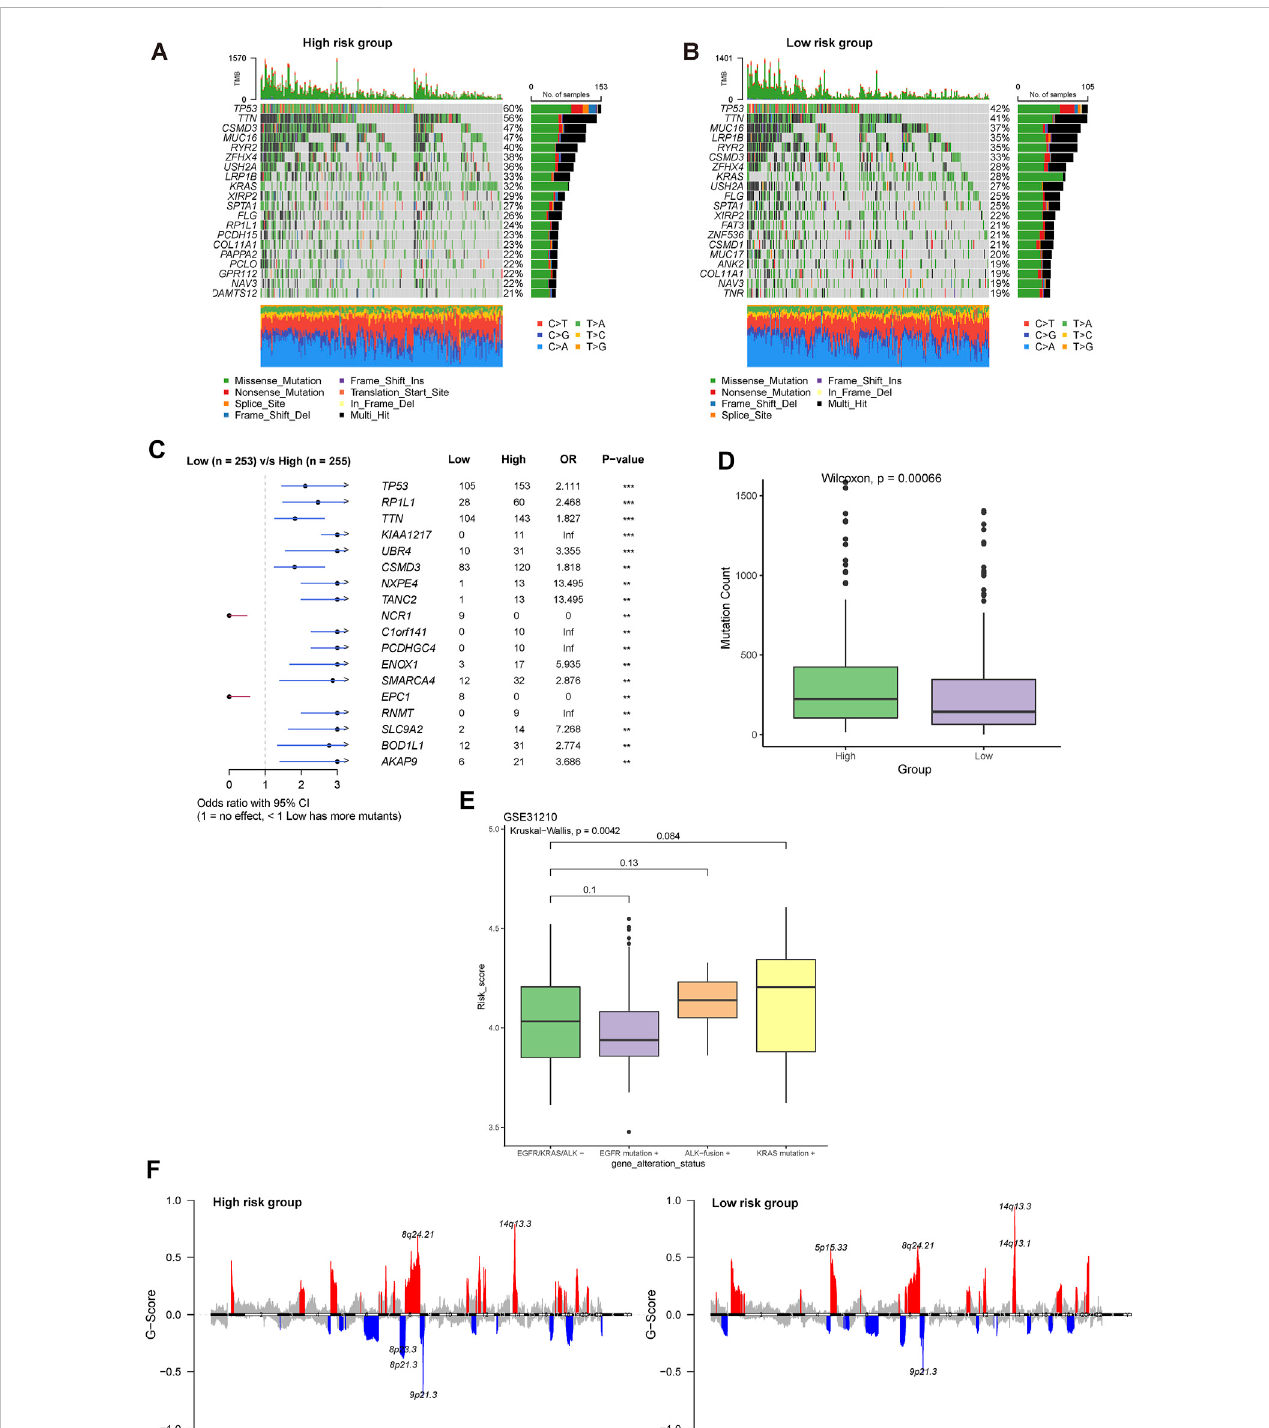
FIGURE 8 Comprehensive analysis of the genomic pro fi les between high- and low-risk groups. Oncoplots showing the top 20 prevalent genes in the (A) high and (B) low-risk groups. (C) Signi fi cantly different prevalent genes in the high- and low-risk groups. **p < .001 and ***p < .0001. (D) Differences in the mutation countsbetweendifferentriskgroups. (E) Differences intheriskgroupamongLUAD patientswithvariousdrivergeneticalterations inEGFR, KRAS,orALKfrom the GSE31210 cohort. (F) Comparison of signi fi cant regions with ampli fi cation or deletion between the high- (left) and low- (right) risk